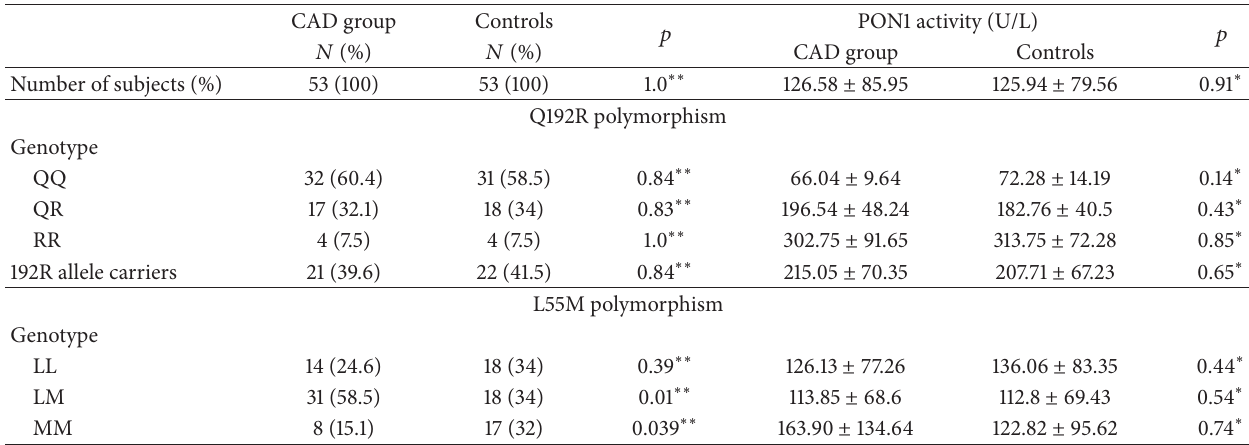
Table 3: The effect of Q192R and L55M polymorphisms on serum PON1 activity. CAD